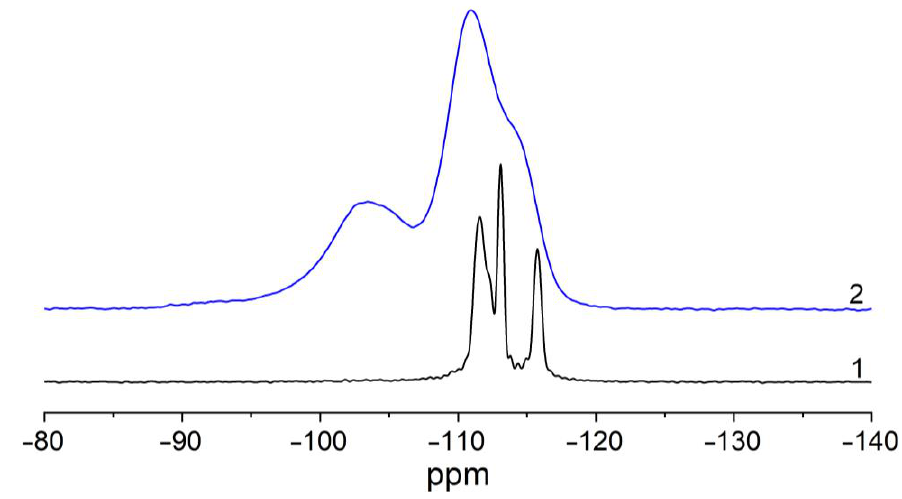
Figure 2. 29 Si MAS NMR spectra of Sn-BEA (1) and BEA (2) zeolite samples.